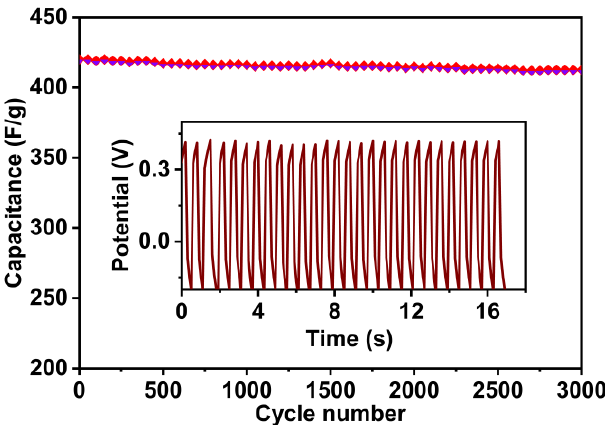
Figure 9. Capacity retention performance after 3000 charge/discharge